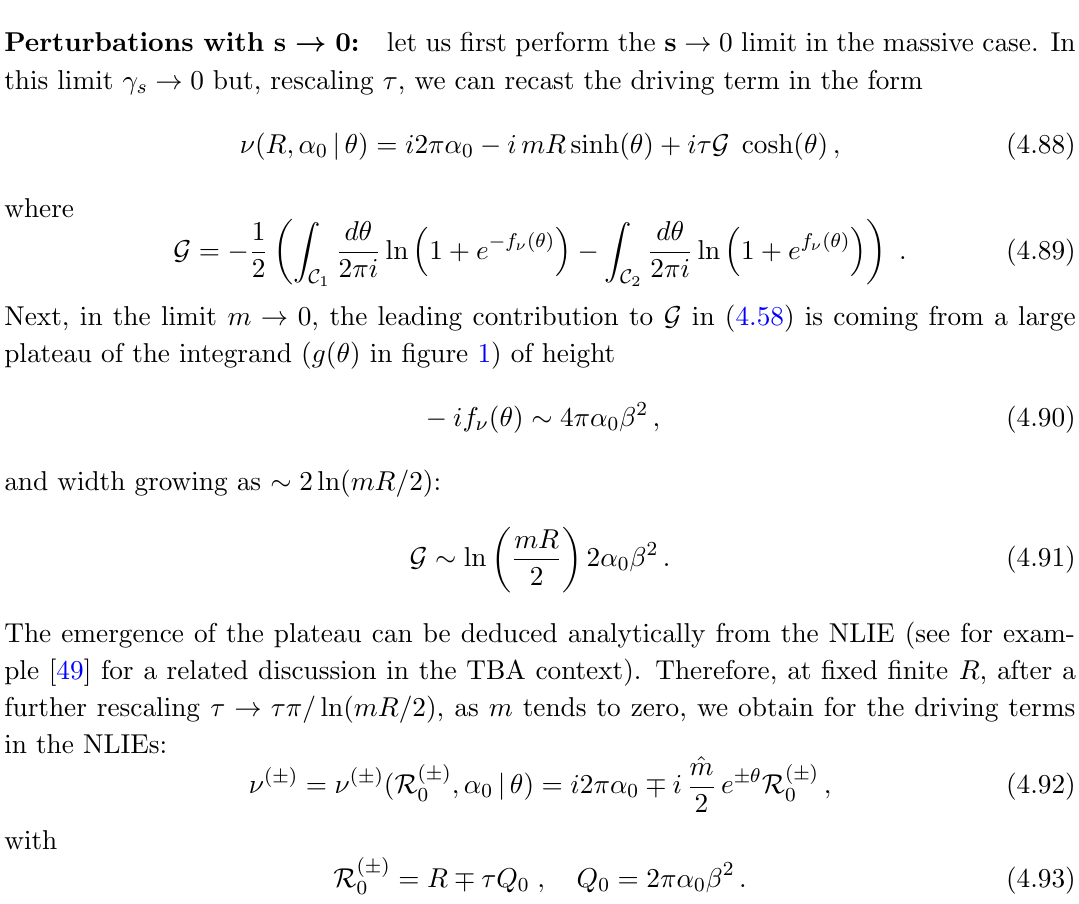
Figure 1 . The formation of the plateau in g ( (cid:18) ) = (cid:0) 1 (cid:12) 2 = 1 = 2, (cid:11) 0 = 1 = 6. For this choice of the parameters, the height of the plateau of g ( (cid:18) ) is 1 =